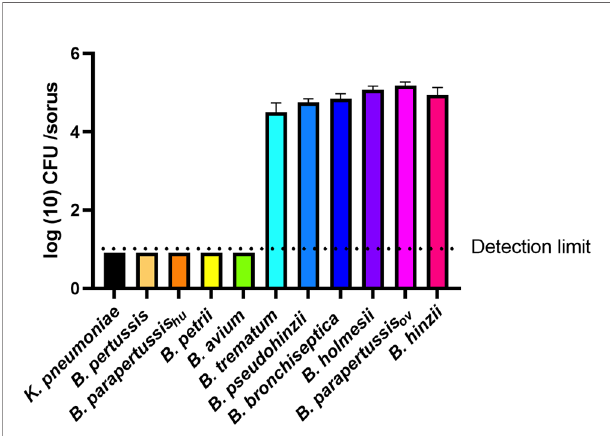
FIGURE 6 | Some Bordetella species can survive inside sori. The sori formed on the lawn of Bordetella species were collected at day 16 post inoculation of amoebae. The bacteria that survived inside sori were enumerated by plating samples on BG agar plates. The colony number will be counted post 48 hours incubation in 37°C. The classical Bordetella species B . bronchiseptica , B. pertussis and B. parapertussis strains, and the non-classical species B . petrii , B. avium , B . trematum , B . pseudohinzii , B. holmesii and B . hinzii , were tested in this assay. The data are based on 3 replicates in each group, error bars show the standard error of